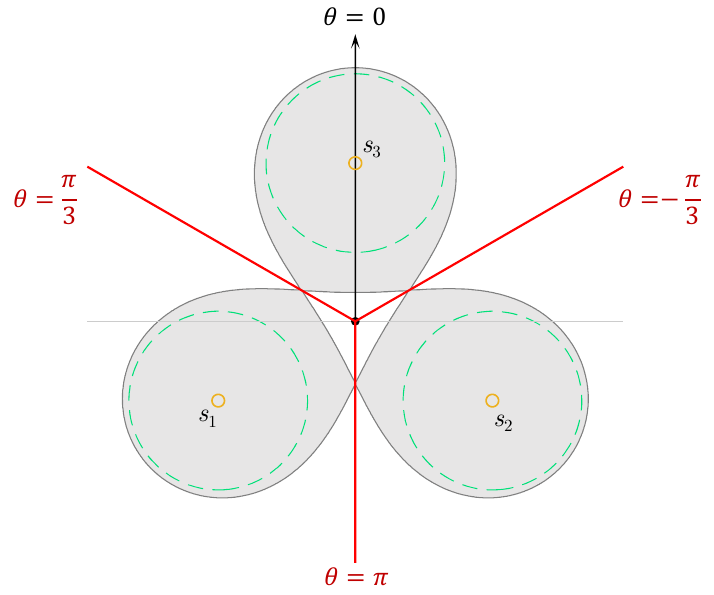
� = � Figure 3. The “last-connection” points are on the mid-perpendicular line of every two adjacent nodes. Theorem 1. Weakest Point